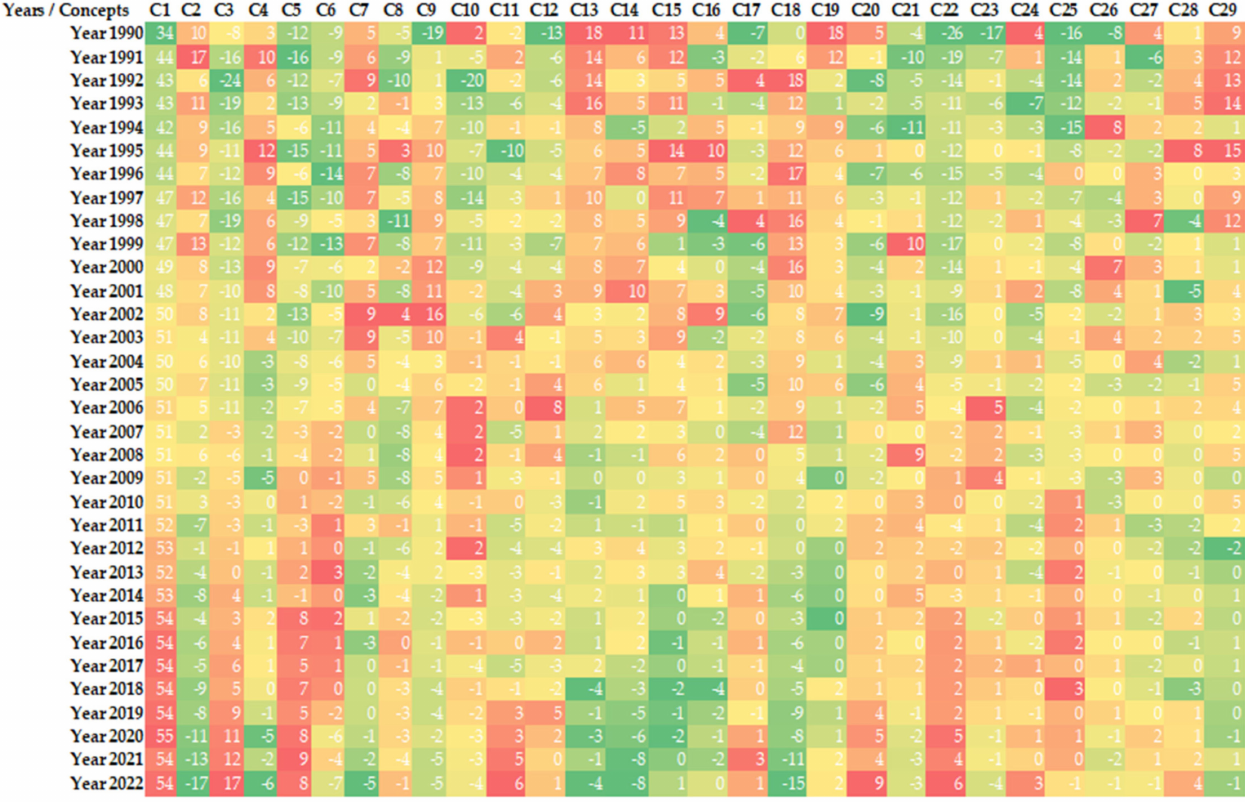
Figure 14. Heatmap of created concepts mean importance weights ( × 10 − 4 ) by